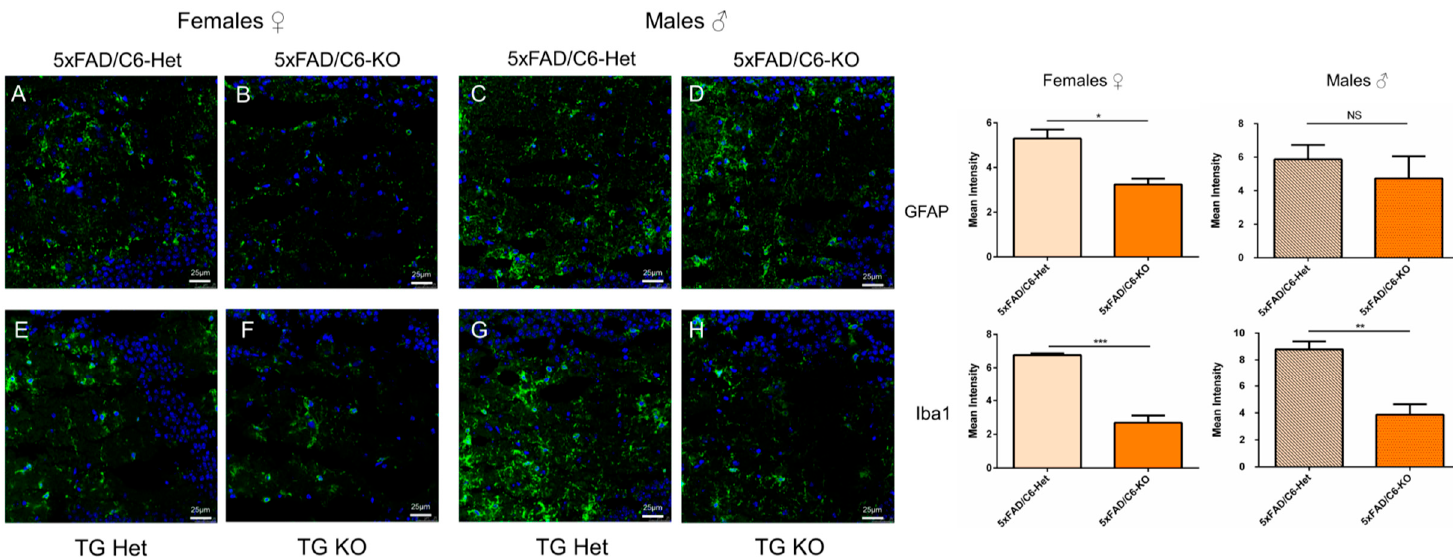
Figure 7. Low IBA1 and GFAP expression in 5xFAD caspase-6 KO mice. Representative images of hippocampal slices stained with GFAP ( A – D ) or IBA1 ( E – H ). Quantification of GFAP and IBA1 are mean intensity of n = Scale bar = 25 µ m. Data are mean ± SEM. * p < 0.05, ** p < 0.01, and *** p < 0.001. Two-tailed t-test.